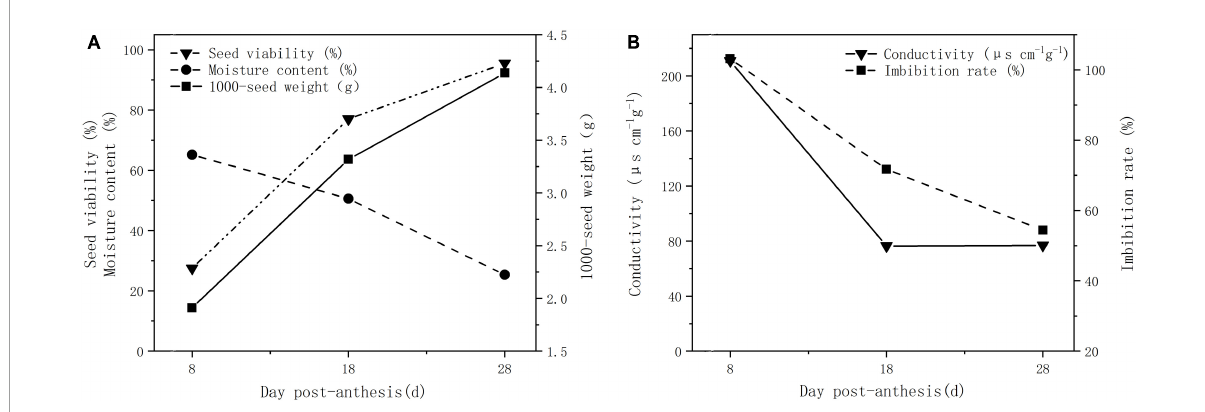
FIGURE1 Physiological indexes of plant seeds at different developmental stages. (A) Seed viability, moisture content, and 1,000-seed weight. (B) EC and imbibition rate.